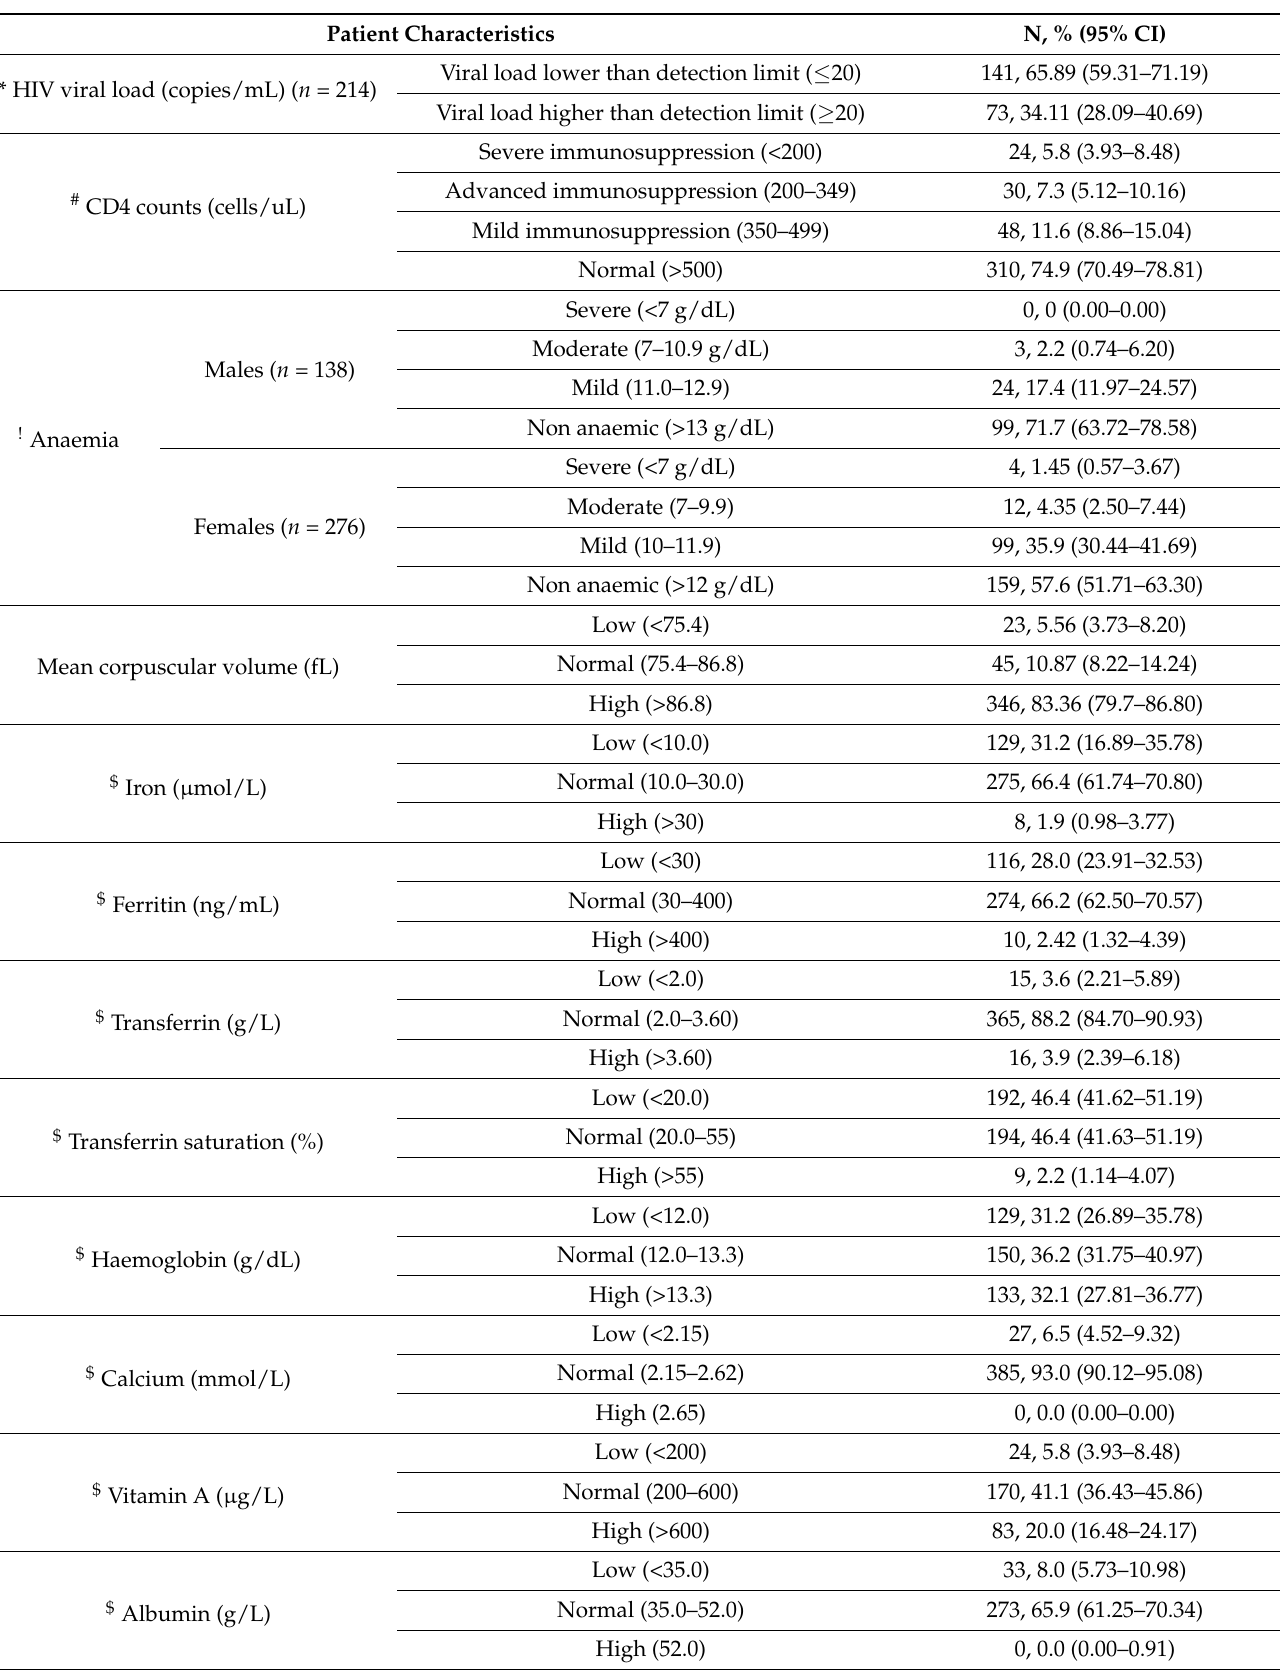
Table 2. Clinical characteristics of all the study participants (N =